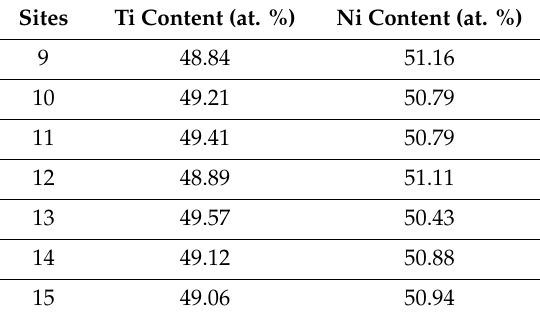
Table 3. Compositional results from EDS measurements, performed in the x–z view. The indication regarding the localization of the region of measurement is indicated in Figure 5a. For all measurements average 0.3% sigma was obtained. Sites Ti Content (at. %) Ni Content (at.